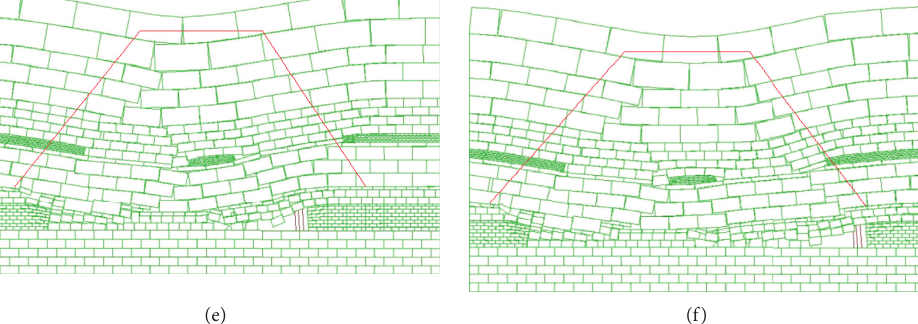
Figure 2: The evolution diagram of collapsing characteristics of overburden rock in 35m interlayer: (a) advance of the working face 40m; (b) advance of the working face 60 m; (c) advance of the working face 80m; (d) advance of the working face 100m; (e) advance of the working face 140m; (f) advance of the working face